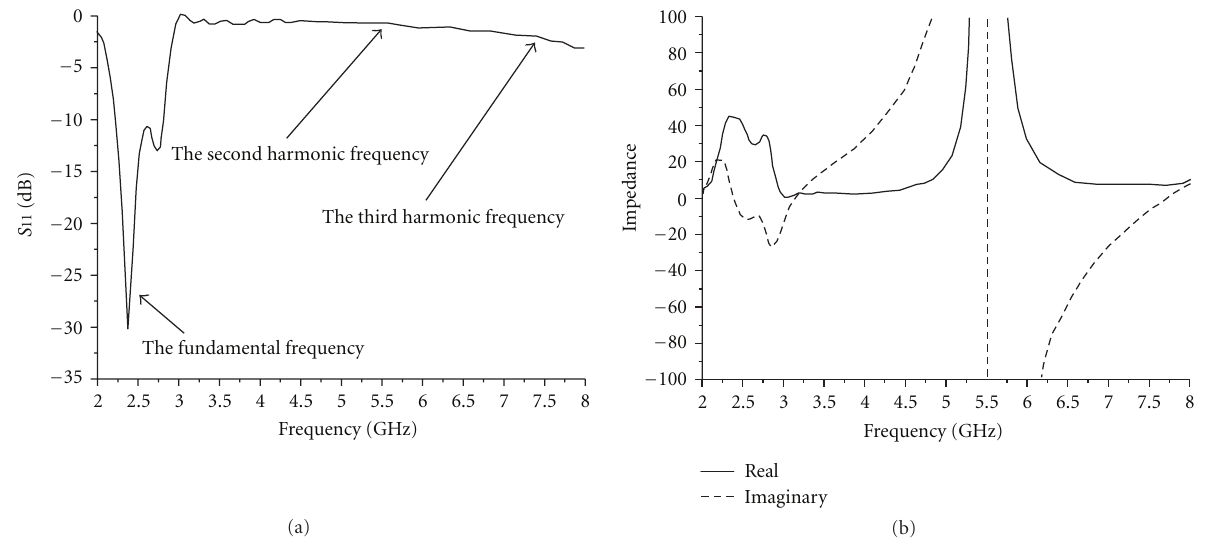
Figure 7: (a) The simulated return losses of antenna 3 and (b) The simulated input impedance of antenna 3.